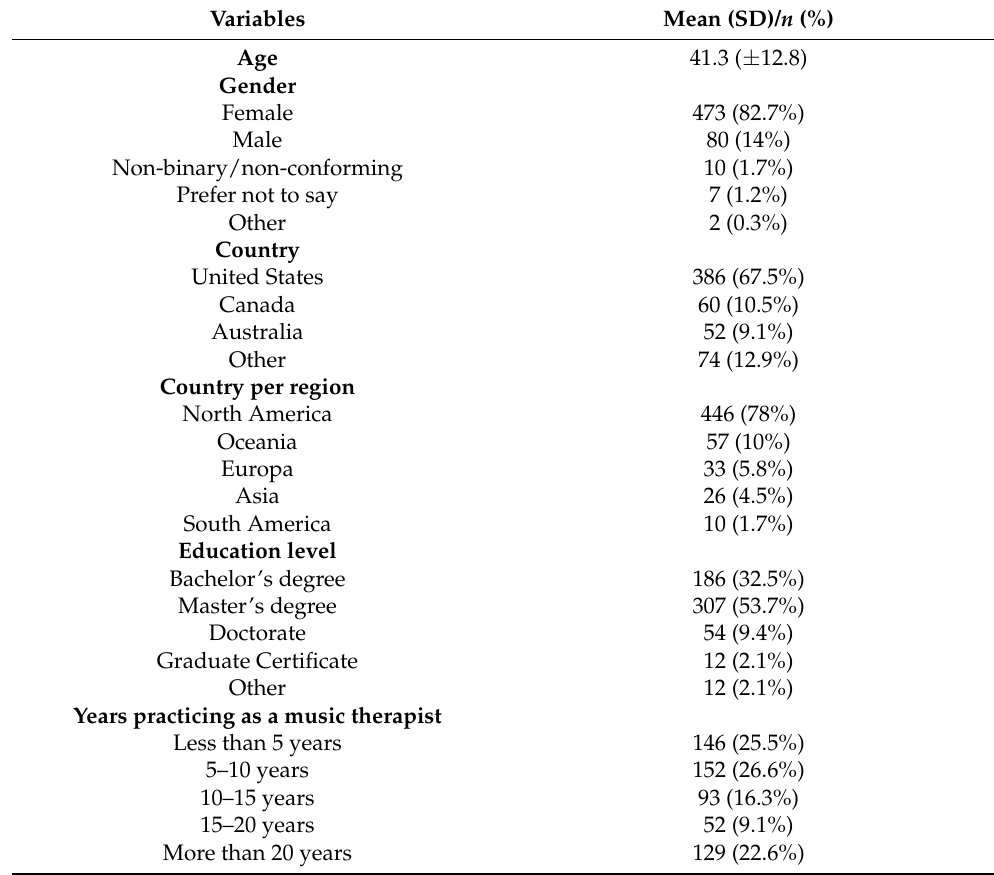
Table 1. Respondent demographics ( n =